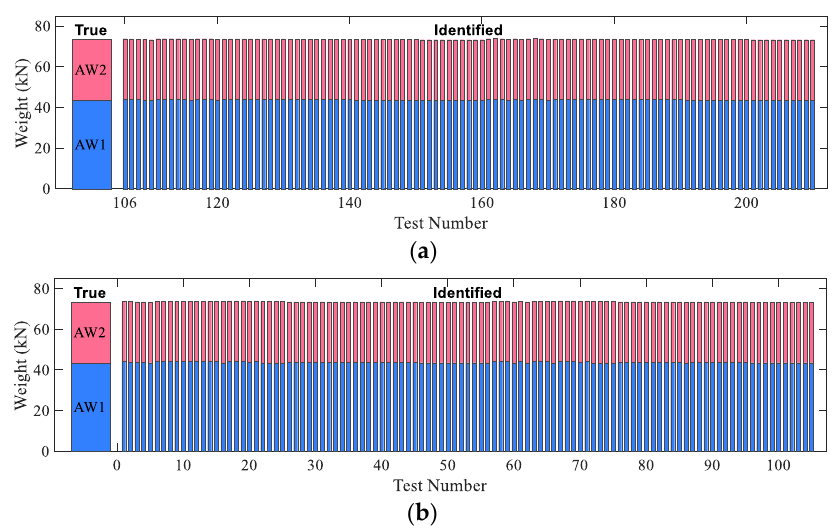
Figure 7. Identified axle weights of the 2-axle truck: ( a ) loading position 1 and ( b ) loading position 2.